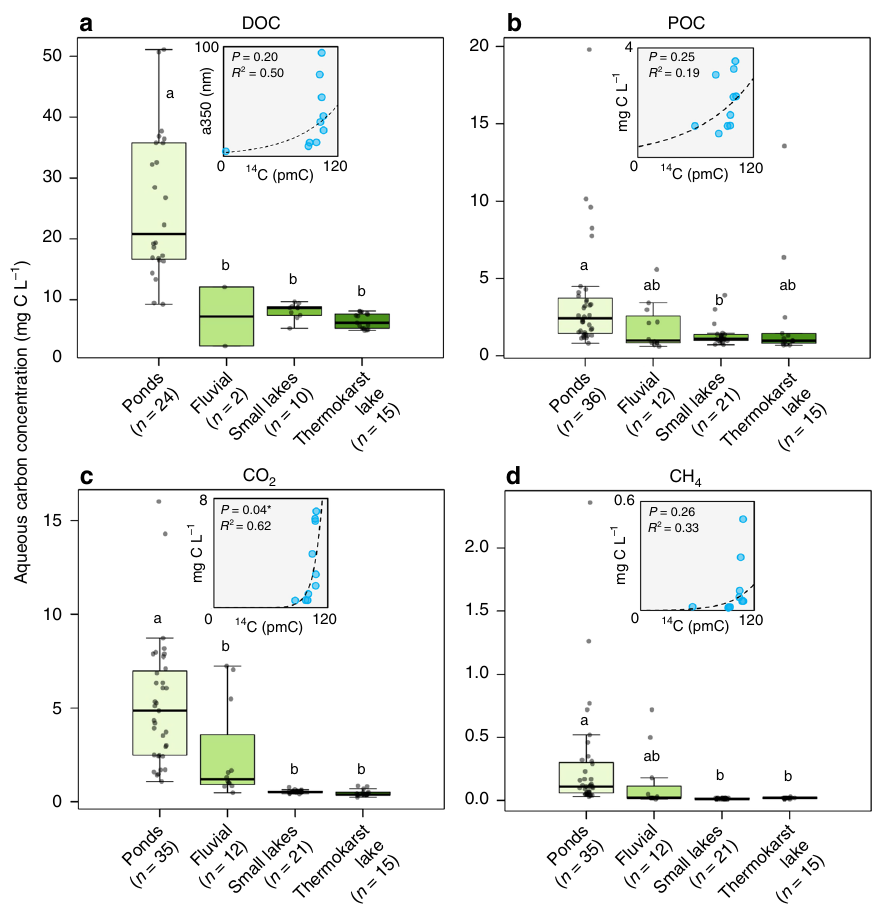
Fig. 4 Concentrations of all carbon forms. a Dissolved organic carbon (DOC), b particulate organic carbon (POC), c carbon dioxide (CO 2 ), and d methane (CH 4 ) for each sample location; the thick horizontal lines represent the median, limits of the boxes represent upper and lower quartiles, whiskers extend to 1.5 times the interquartile range, dots represent all data points, letters indicate statistical differences between the sample locations using ANOVA (see Methods). Inset: relationship between 14 C content and carbon concentrations (absorbance at 350 nm [a350] for DOC; Supplementary Fig. 4) 46 , excluding Yedoma meltwater (see Methods) (*indicates P <